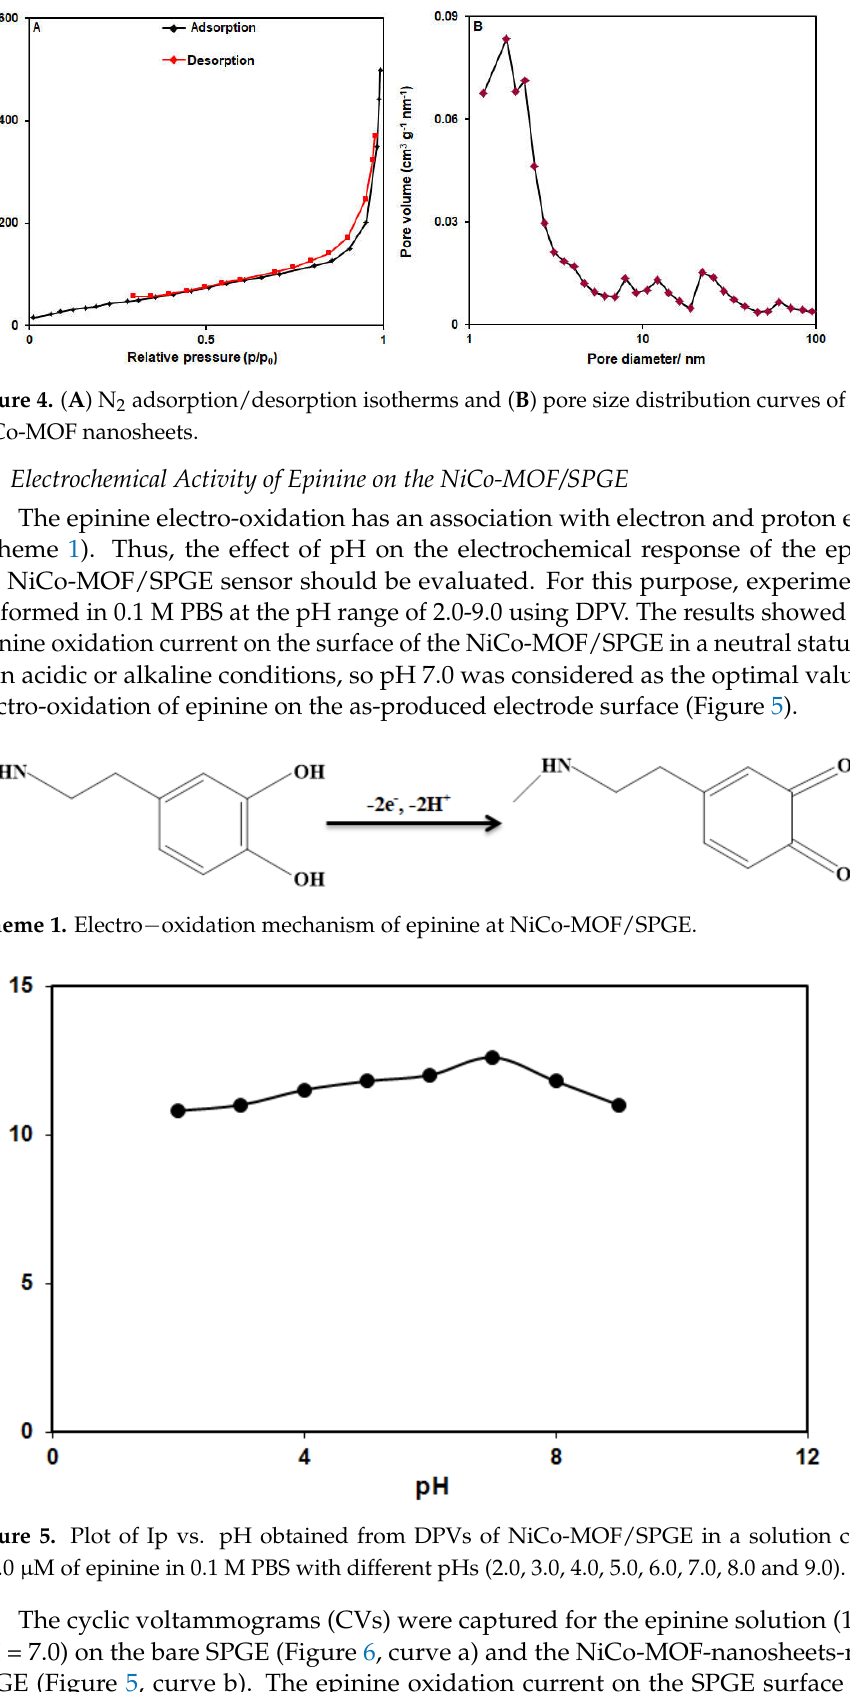
Figure 6. Cyclic voltammograms captured of (a) bare SPGE and (b) NiCo-MOF/SPGE for epinine (100.0 µM) in PBS (pH 7.0; 0.1 M) at scan rate of 50 mV/s. 2.3. Analysis of Scan Rate Effect The electrochemical response of epinine on the NiCo-MOF/SPGE was evaluated using the CV method. Figure 7 shows the CVs captured for epinine (100.0 µM) on the NiCo-MOF/SPGE in PBS (pH = 7.0, 0.1 M) at variables scan rates. Figure 6 (inset) depicts the anodic peak current (Ipa) of the epinine, representing a linear relationship with the